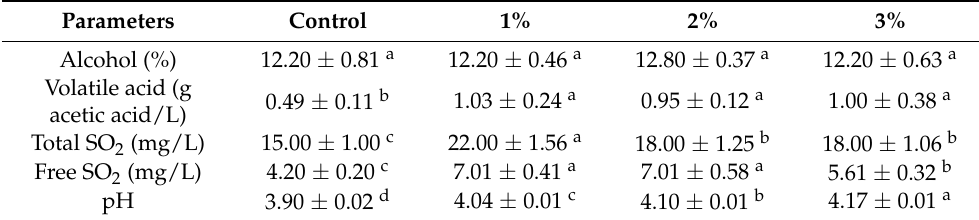
Table 1. Basic oenological parameters of mulberry fermented alcoholic beverages containing different amounts of mulberry leaf powders (on Day 9).